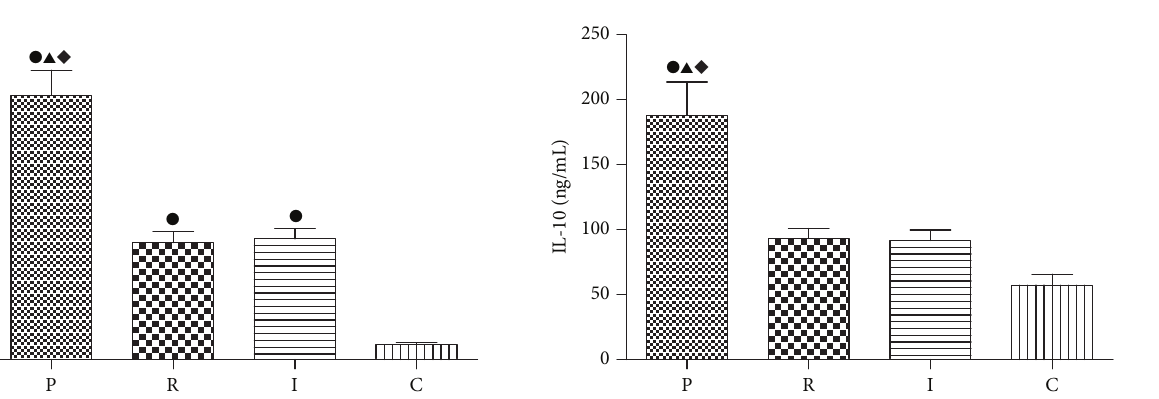
Figure 7: Quantitative assays for protein levels of IL-10 in the BAL fluid. PAO1 group (P), Δ lasI Δ rhlI group (I), Δ lasR Δ rhlR group (R), and control group (C). e : compared with control group, 𝑝 < 0.05 . 󳵳 : statistically significant differences between PAO1 and Δ lasR Δ rhlR group, 𝑝 < 0.05 . X :statisticallysignificantdifferencesbetweenPAO1 and Δ lasI Δ rhlI group, 𝑝 < 0.05